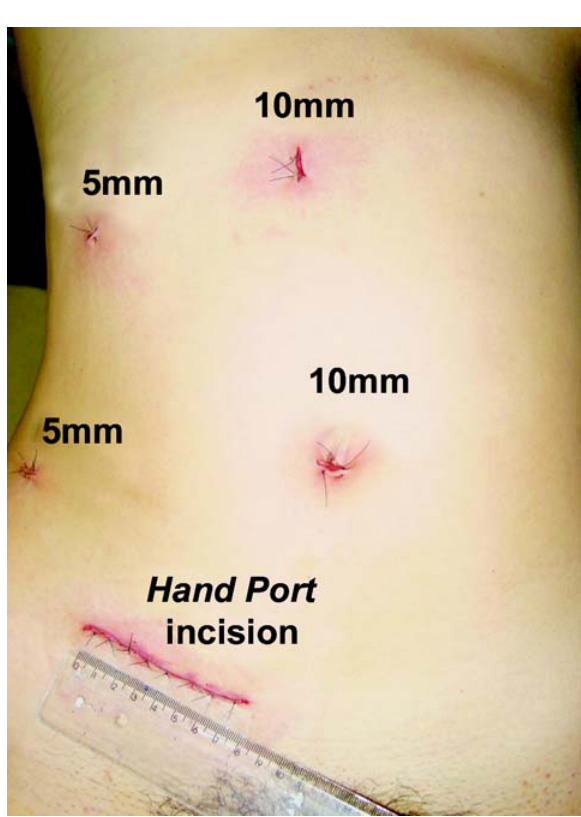
Figure 8 – Final aspect of the surgery.